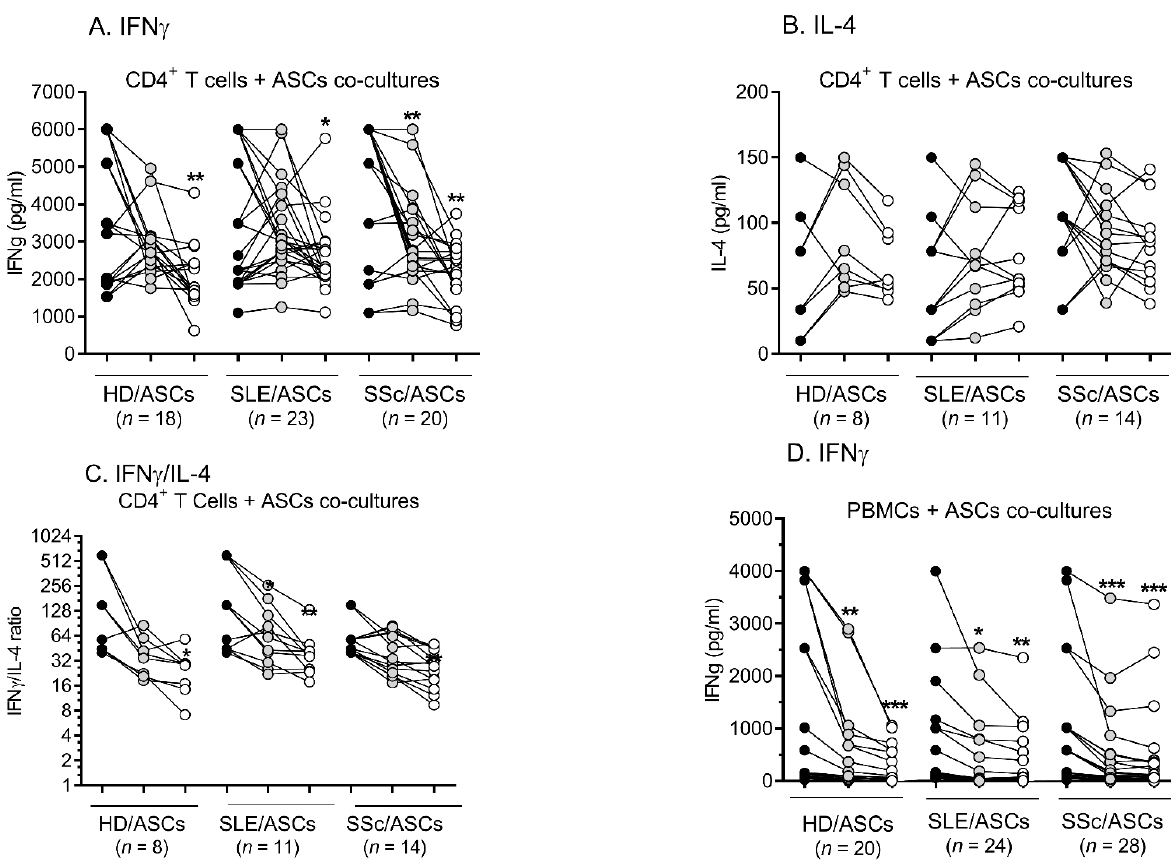
Figure 4. The production of IFN γ and IL-4 in individual experiments. Cell preparation, culture conditions, and the explanations as described in Figure 3. Lines between points identify cultures containing the same combination of ASCs and activated T cells ( A – C ) or activated PBMCs ( D ). Data are shown as the cytokine concentrations ( A , B , D ) or the IFN γ /IL-4 ratio ( C ). Black circles—separately cultured activated control target cells ( act T cells or PBMCs PHA ); grey circles—activated target cells + ASCs; unfilled circles—activated target cells + ASCs TI . * p = 0.05–0.01; ** p = 0.01–0.001; *** p = 0.001– 0.0001 for intra-group comparison; the inter-group differences were statistically insignificant. As shown in Figure 5, in the co-cultures of ASCs with both types of target cells, the secretion of IL-17AF was significantly up-regulated in the presence of ASCs from healthy donors as well as from the patients. This increase was seen in almost every experiment, and there was no significant difference between co-cultures with HD/ASCs versus (vs.) SLE/ASCs and SSc/ASCs.